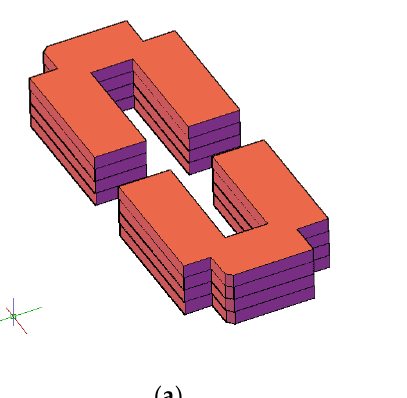
Figure 9. Master plans of ( a ) BC2, ( b ) C2DS1, and ( c ) C2DS2; buildings in grey, grass in light green, and trees in dark green. The red ellipses indicate the location of the high buildings used to help UCL wind mixing.